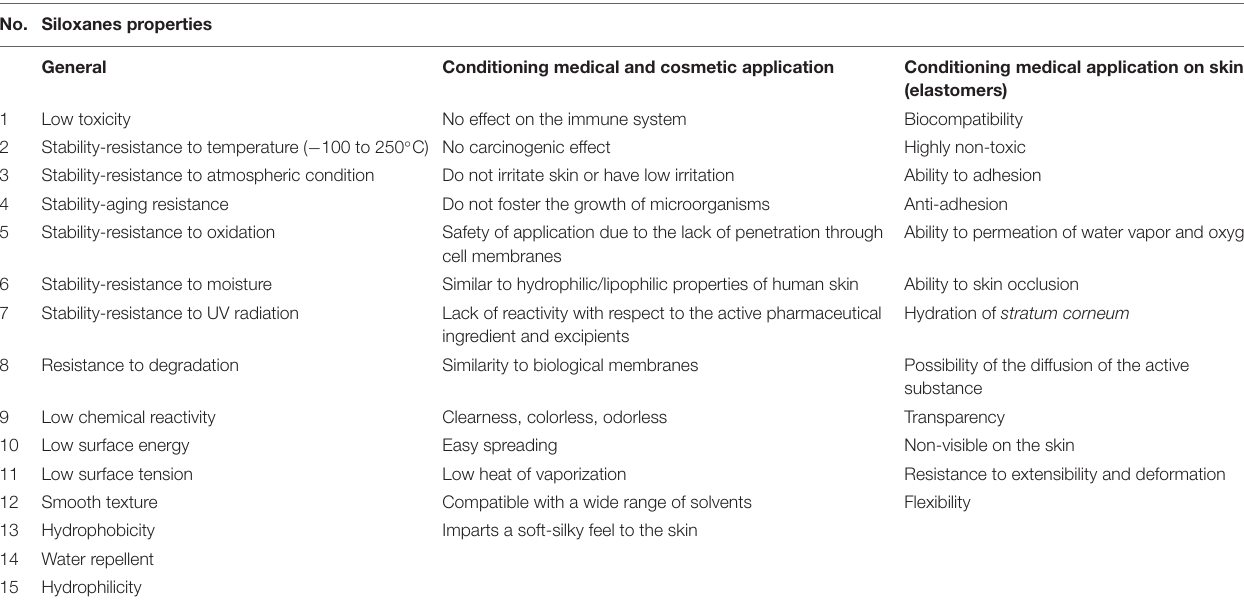
TABLE 2 | The most important features of siloxanes used in medicinal products, medical devices and